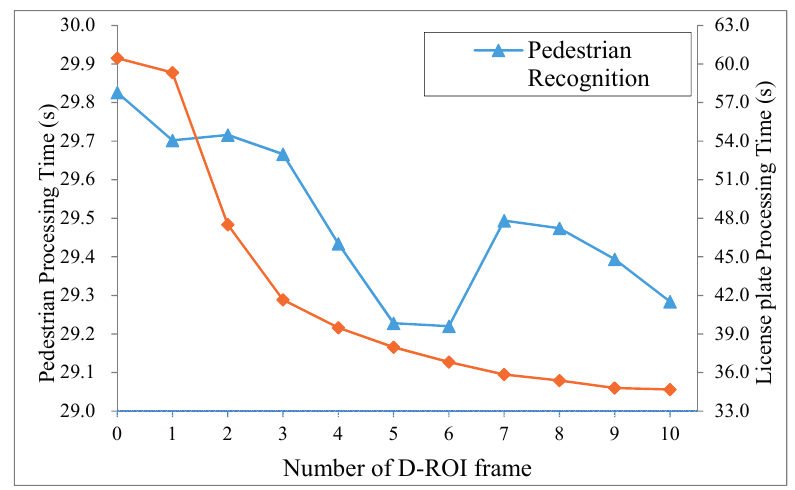
Figure 7. Recognition processing time for the number of D-ROI